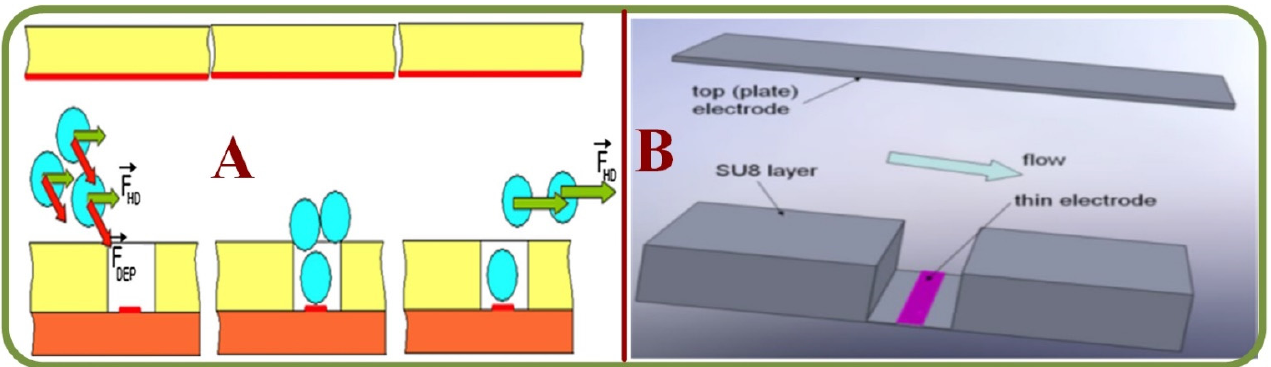
Figure 16. Examples of single RBC trapping arrays ( A ) A trapping device and cell patterning method using eDEP and iDEP [329]. ( B ) A single cell patterning method by using a strong DEP force, and removing unwanted cells by the hydrodynamic force [329].